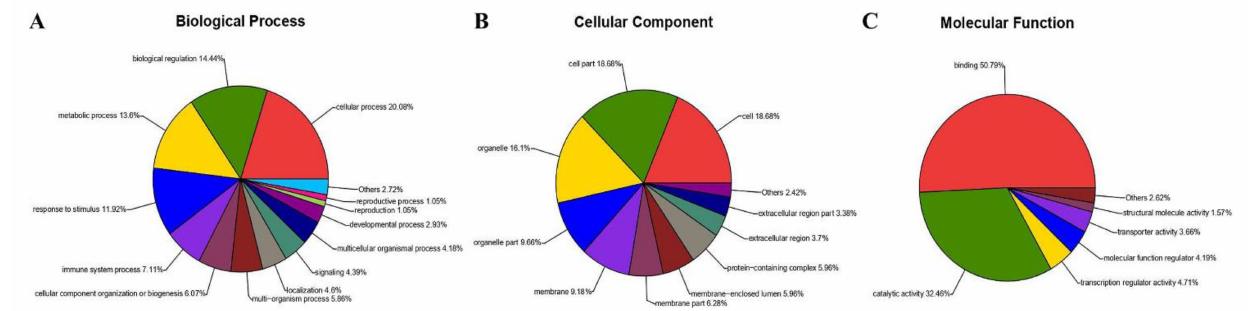
Figure 7. Gene ontology analysis of 327 proteins differentially expressed in MDBK cells infected with CpHV-1. Proteins were annotated by biological process ( A ), cellular component ( B ), and molecular function ( C ). Each color represents a different GO term, and the percentages of protein numbers in each category are shown after the name of the GO term. A detailed representation of the data is provided in Table